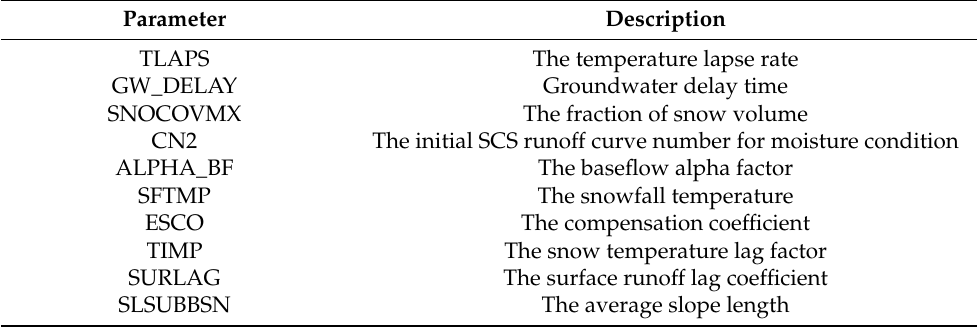
Table A1. Description of sensitive parameters for stream flow in SWAT.